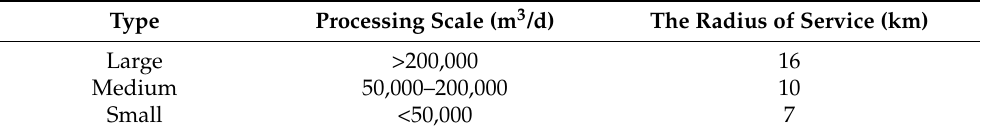
Table 6. Scale of wastewater treatment